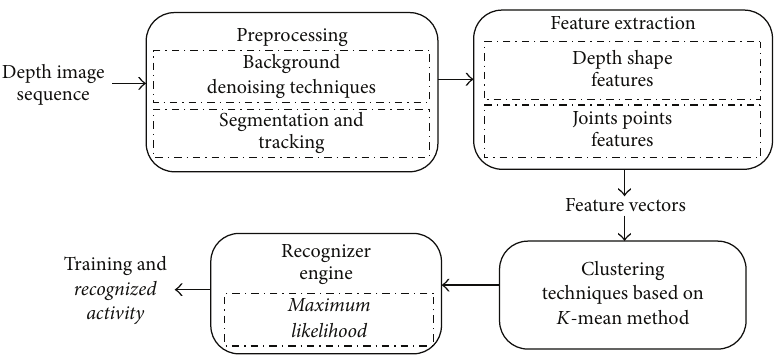
Figure 1: System architecture of the proposed human activity recognition